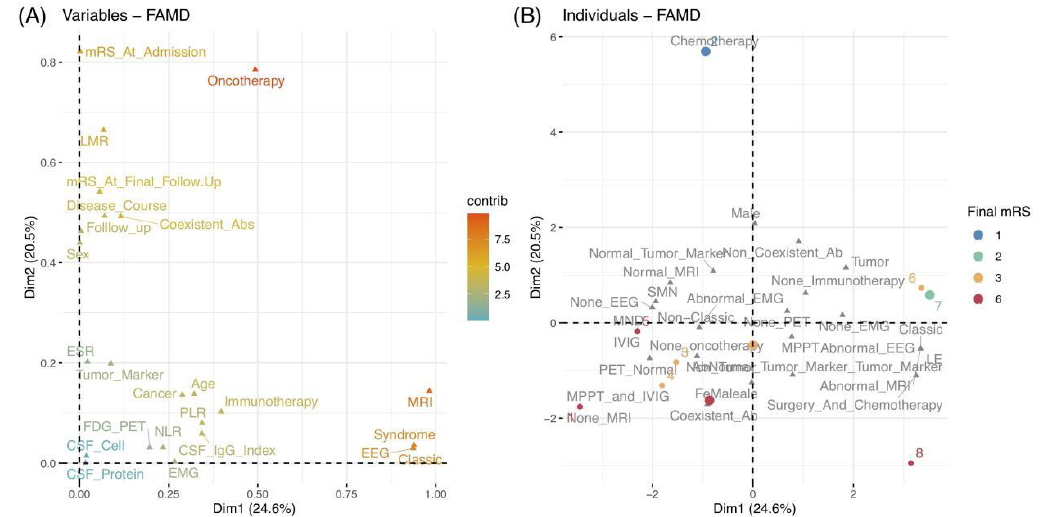
Figure 4. ( A ) Correlations between quantitative and qualitative variables in the first quadrant of 2 Dims by the value of the contributions. ( B ) Plot of 8 individuals colored by their mRS scores at the final follow-up. Abbreviations: ab, antibody; CSF, cerebrospinal fluid; Dim, dimension; EEG, electroencephalograms; EMG, electromyography; ESR, erythrocyte sedimentation rate; FAMD, factor analysis of mixed data; FDG-PET, 18 F-fluorodeoxyglucose positron emission tomography; IVMP, intravenous methylprednisolone; IVIG, intravenous immunoglobulin; LE, Limbic encephalitis; LMR, lymphocyte- to-monocyte ratio; MND, motor neuron diseases; MRI, magnetic resonance imaging; mRS, modified Rankin Scale; NLR, neutrophil-to-lymphocyte ratio; PLR, platelet-to-lymphocyte ratio; SMN, sensorimotor